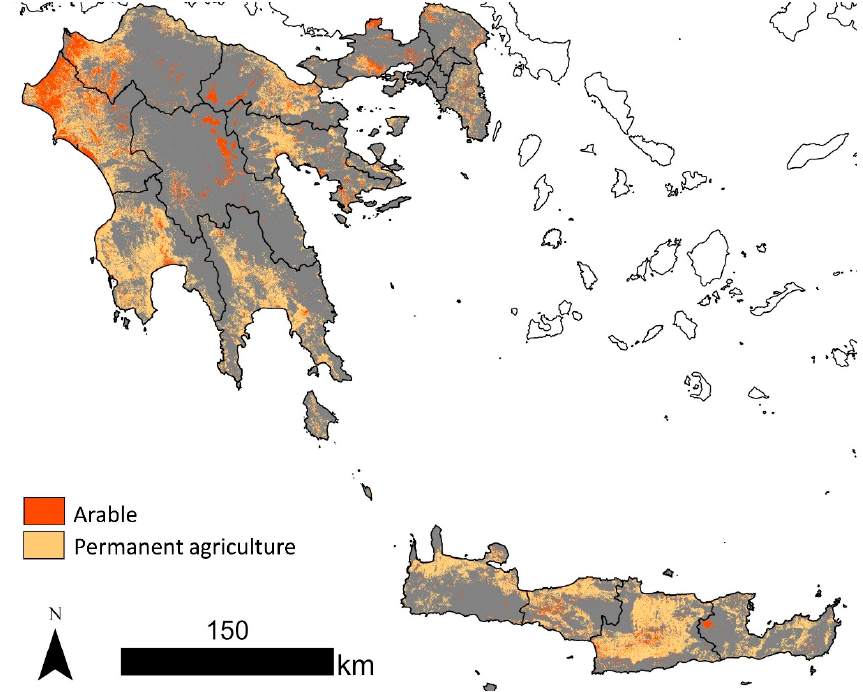
Figure 5. Arable and permanent agriculture classification map over the study area in the year 2020.